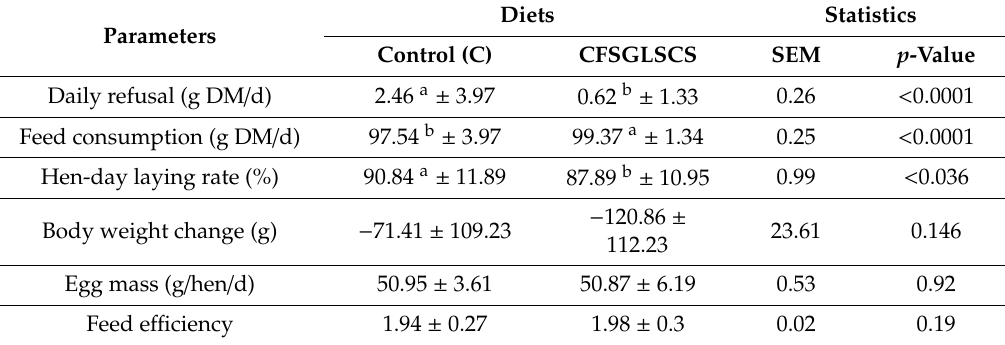
Table 2. E ff ects of various diets on the laying hen